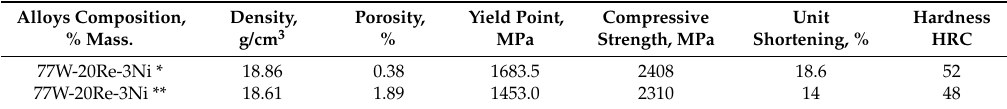
Table 6. Selected properties of 77W-20Re-3Ni heavy